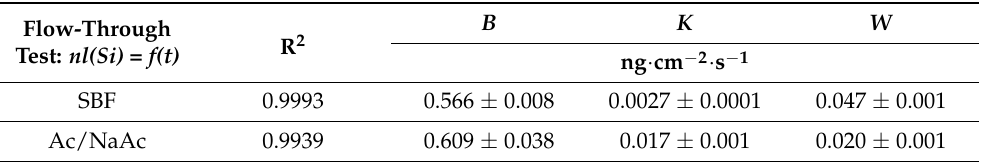
Table 4. Empirical parameters with RSD% ≤ 2 as determined from fitting the nl(Si) flow-through data with Equation (2) when estimated for dissolution in SBF (pH of 7.4) and Ac/NaAc (pH of 4).